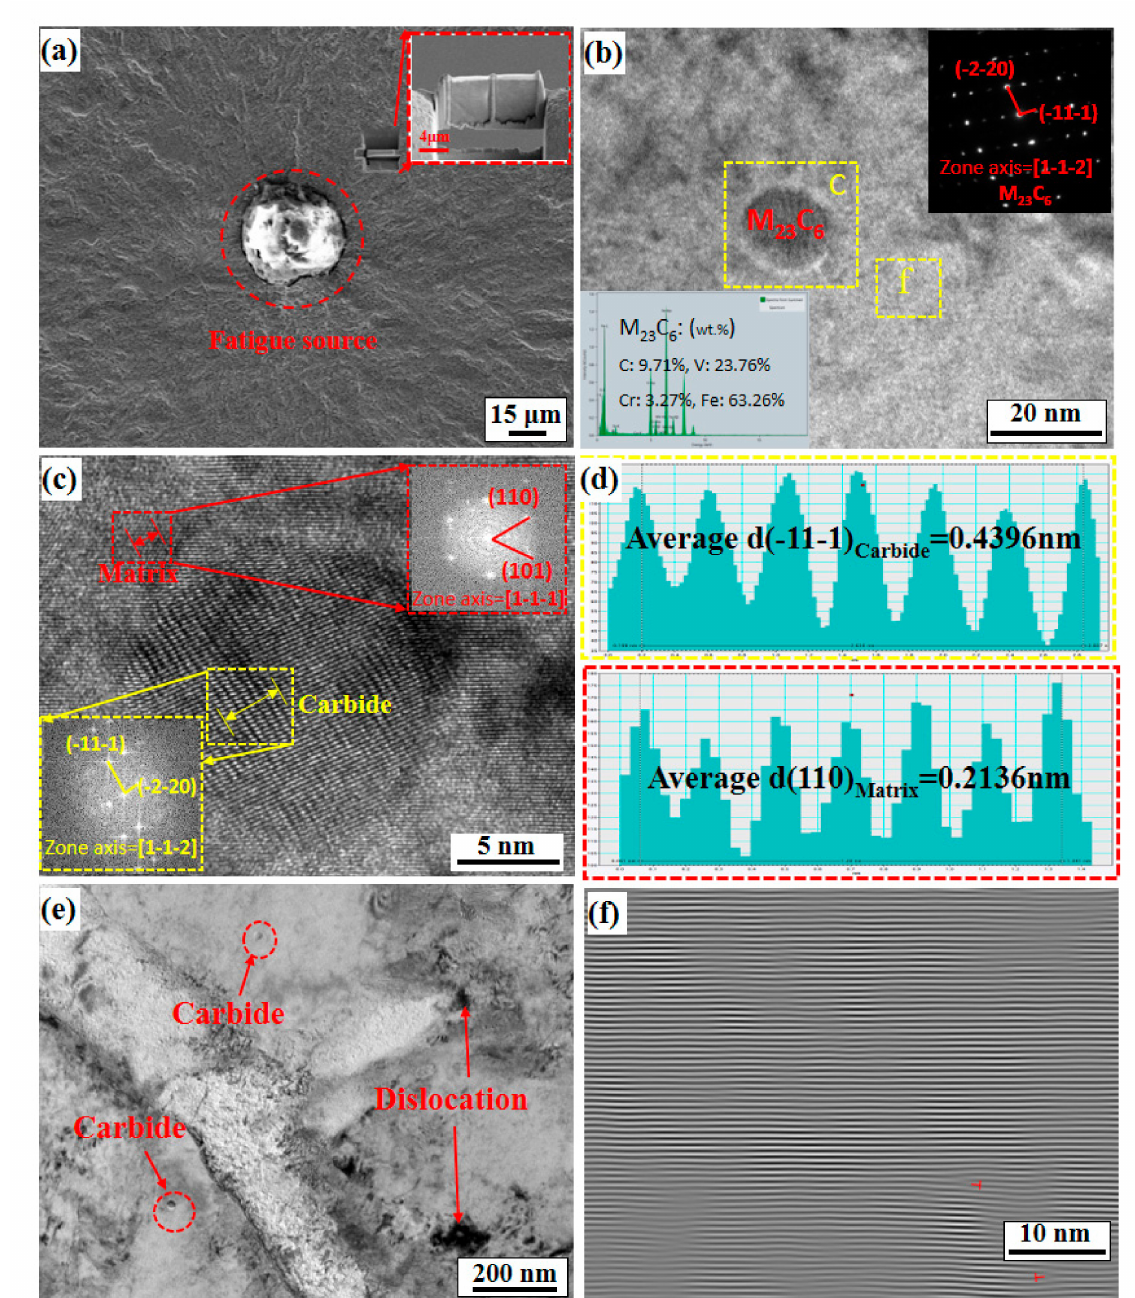
Figure 11. Microstructure image of the results of the axial fatigue test ( σ = 870 MPa, A = 0.851, and N f = 5.32 × 10 5 cycles): ( a ) sampling location of SEM-FIB; ( b ) TEM image of M 23 C 6 carbides; ( c ) HRTEM images and the corresponding Fourier spot for region c in ( b ), suggesting that the relationship between the M 23 C 6 precipitate and the matrix follows the [1-1-2] M23C6 //[1-1-1] bcc-Fe orientation relationship; ( d ) the interplanar crystal spacing of the (-11-1) M23C6 phase and (110) α -Fe , respectively; ( e ) TEM image of the microstructure of the fisheye area; and ( f ) the corresponding FFT pattern for region f in ( b